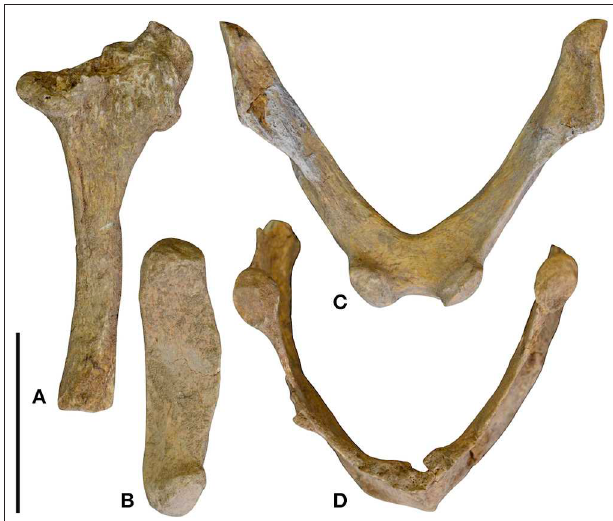
FIGURE 4 | Hyoid apparatus of Catonyx tarijensis MNHN-Bol V 13364 from the Pleistocene of Oruro (Bolivian Altiplano). Right stylohyal in medial view (A) ; right epihyal in medial view (B) ; V-bone in anterior view (C) ; and ossified thyroid cartilage in anterior view (D) . Scale bar equals